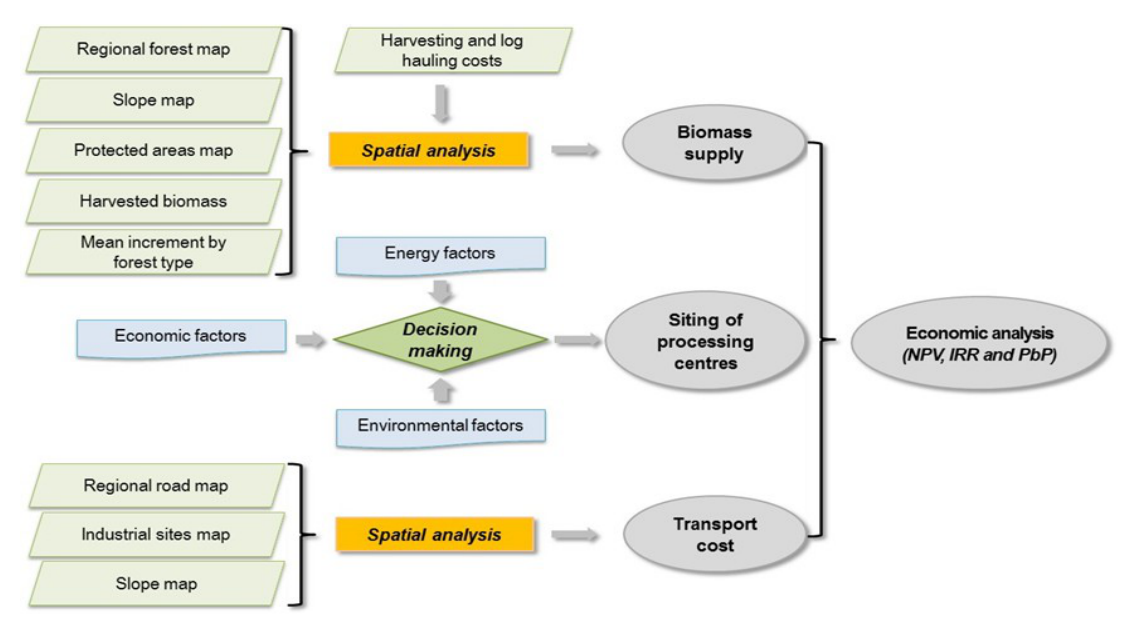
Figure 1. Methodology